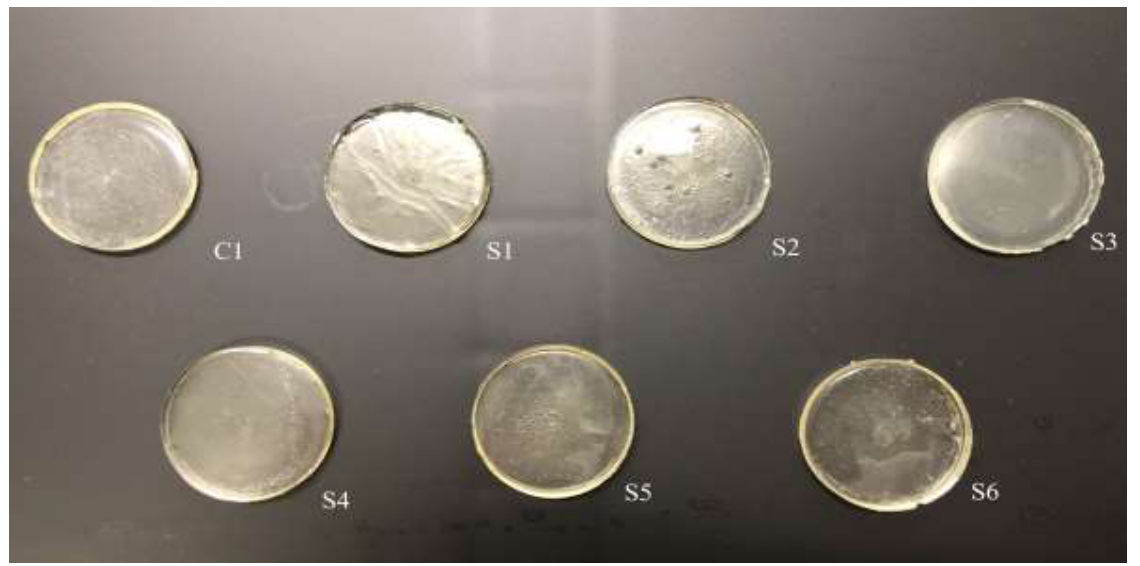
Figure 2. The appearance of the prepared disc xerogels.